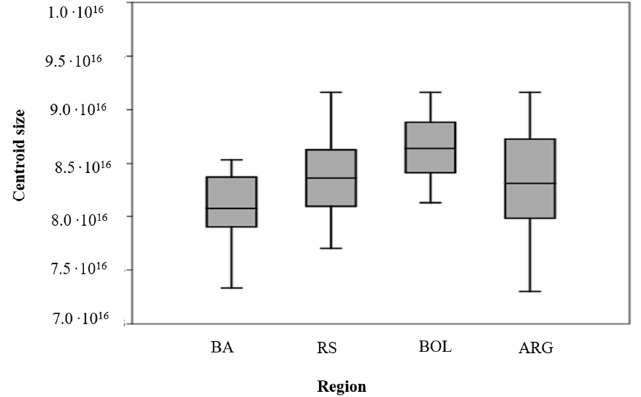
Figure 7. Box diagram of the centroid size of T. infestans populations from different regions BA/Ba- hia/Residual Foci (TI169); RS/Rio Grande do Sul (TI24, TI27, TI28, TI131, TI156 Residual foci); Bo- livia/Cochabamba (TI165), Argentina/ARG (Córdoba) (TI25); Argentina/ARG/Santa Fé (TI26). Bolivia/Cochabamba (TI165), Argentina/ARG (C ó rdoba) (TI25); Argentina/ARG/Santa F é (TI26). Mahalanobis distance values retrieved from show morphometric dissimilarity in size between male heads (Table 3). All values are statistically supported (<0.001). The values show that the populations of the Argentine group are more distant, with less difference with the Rio Grande do Sul group, Brazil. Bolivia’s population is far from all populations. The population of Bahia, Brazil, according to the sampled data, is different from the other Bra- zilian population (Table 3). Table 3. Mahalanobis distances between populations of T. infestans from different regions. Regions